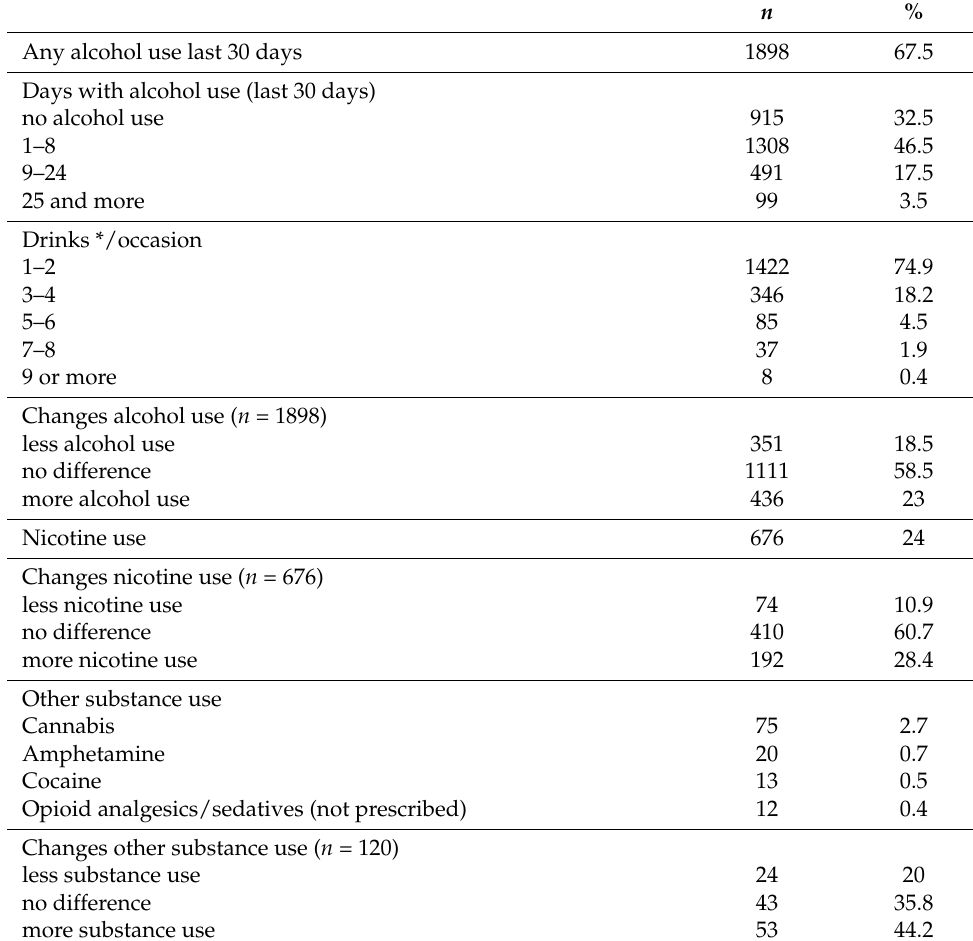
Table 3. Description substance use under pandemic conditions.